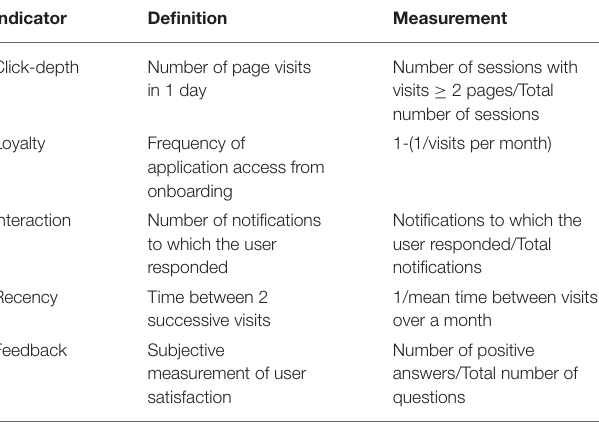
TABLE 3 | Information measurements. TABLE 4 | Interaction